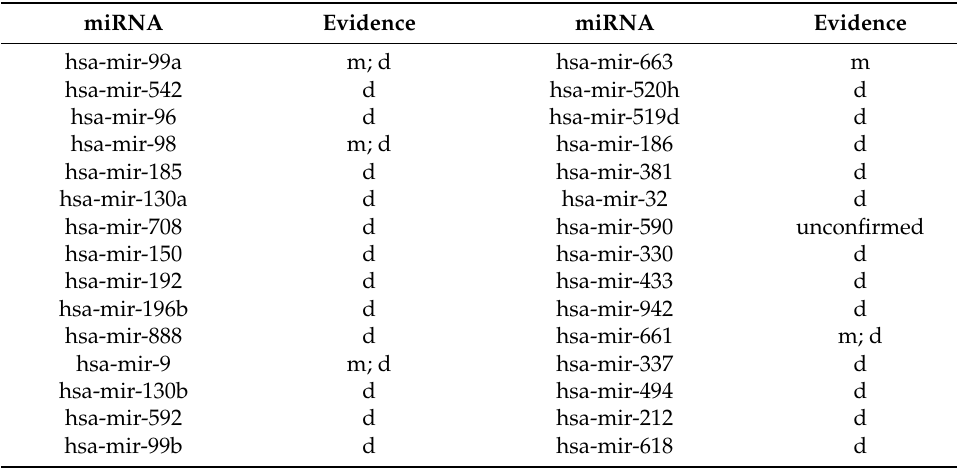
Table 2. The top 30 potential miRNAs associated with breast neoplasms. miRNA Evidence